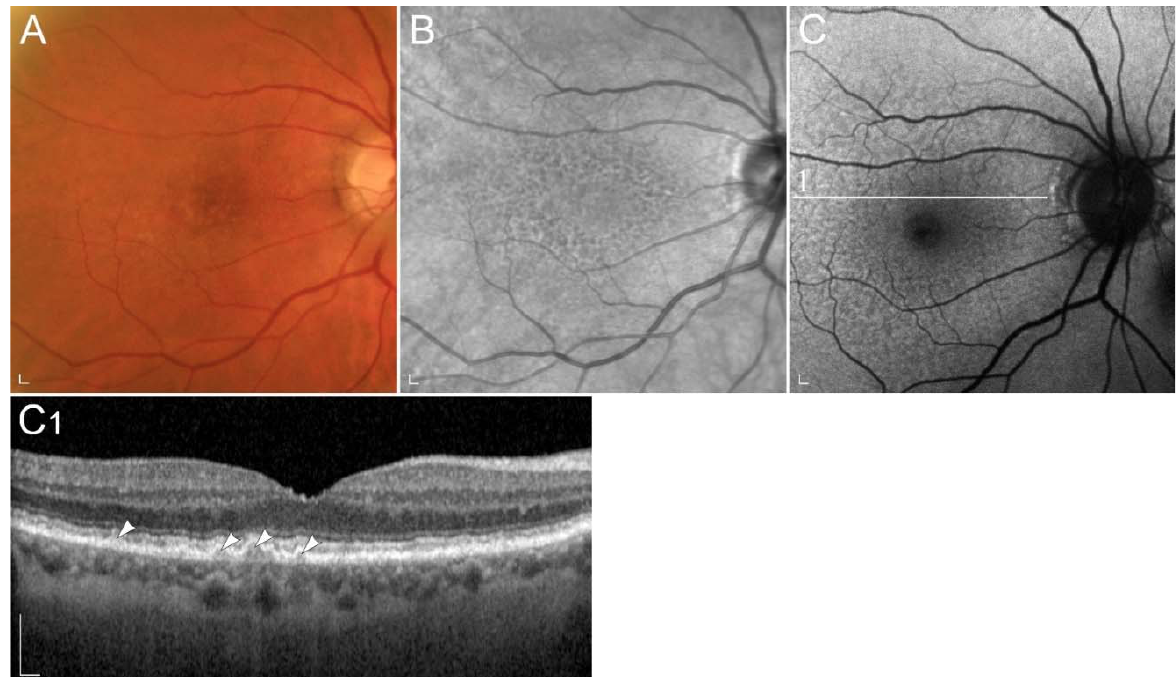
Figure 8. Patient with age related macular degeneration. Representative ( A ) colour fundus image, ( B ) fundus infrared image and ( C ) FAF image with corresponding ( C1 ) SD-OCT image show (arrow- heads) reticular drusen. Patient’s best corrected Snellen decimal visual acuity was 0.8 on both eyes. Scale bars: 200 µ m. Source: Eye Hospital, University Medical Centre Ljubljana.